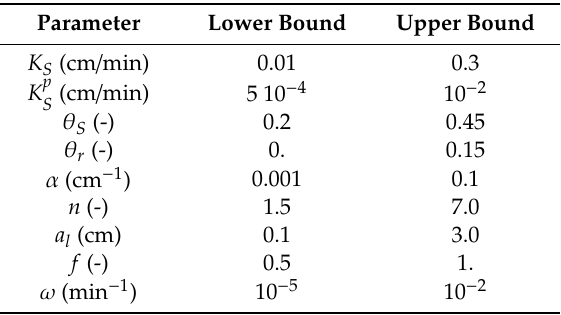
Table 1. Ranges of the soil